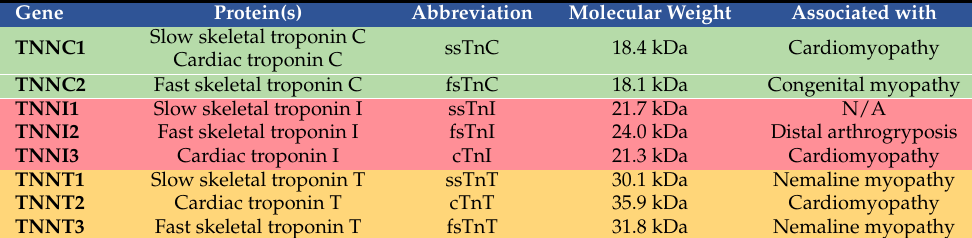
Table 1. Genes encoding troponin proteins and the abbreviations